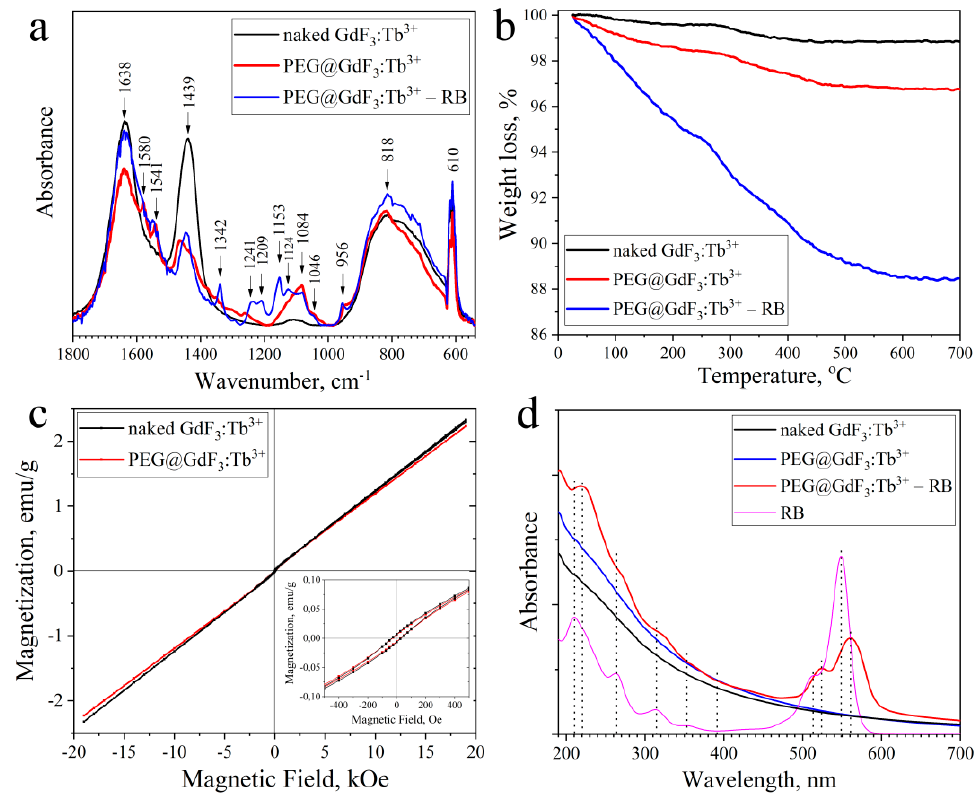
Figure 2. ( a ) FTIR spectra; ( b ) TG curves; ( c ) Room-temperature magnetization curves, and ( d ) UV-Vis absorption spectra of naked and PEG-capped GdF 3 :Tb 3+ (10%) nanoparticles